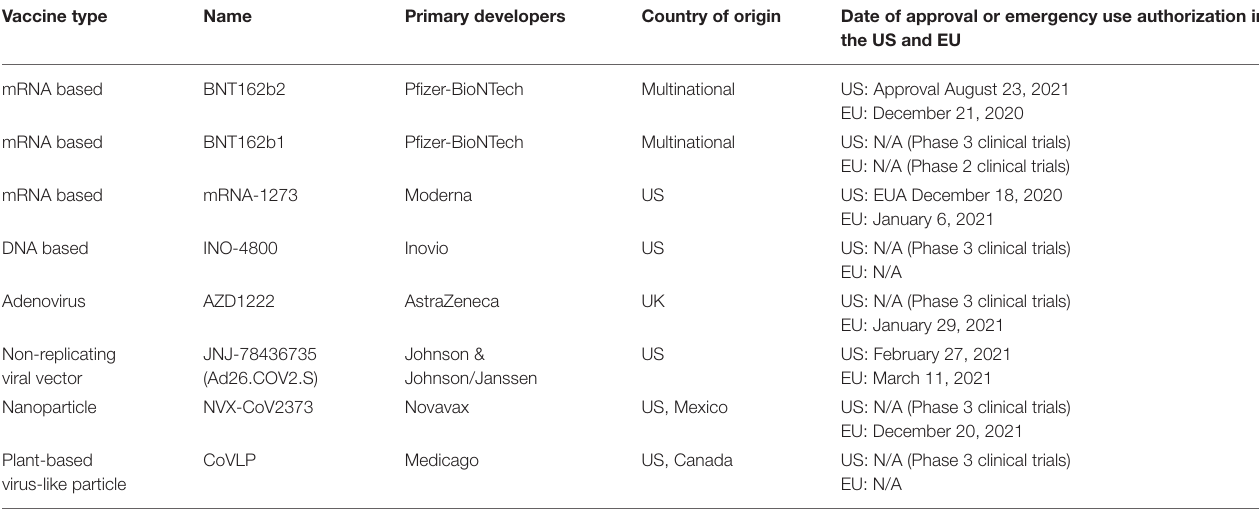
TABLE 2 | COVID-19 vaccines authorized for emergency use † or in phase 3 development in the US as of October 20, 2021. Vaccine